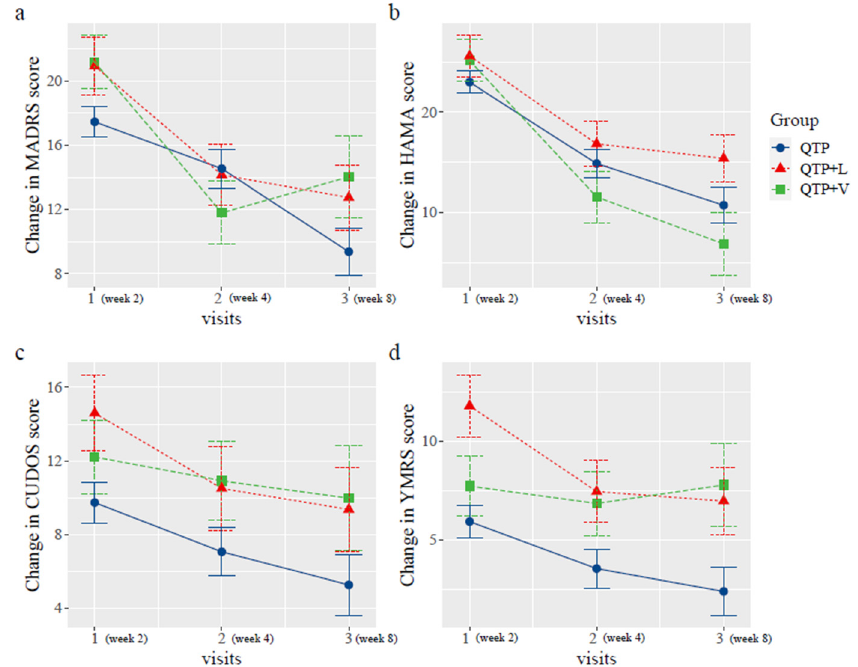
Figure 3. Change of MADRS, HAMA, CUDO-MS and YMRS scores of QTP, QTP + L and QTP+S during six weeks treatment. QTP: quetiapine group; QTP + V: quetiapine plus valproate group; QTP + L: quetiapine plus lithium group; analyses were conducted with the use of a generalized linear mixed model, treating group as fixed effect, patient ID as random effect, time * group as interaction and age, sex as explanatory variables.